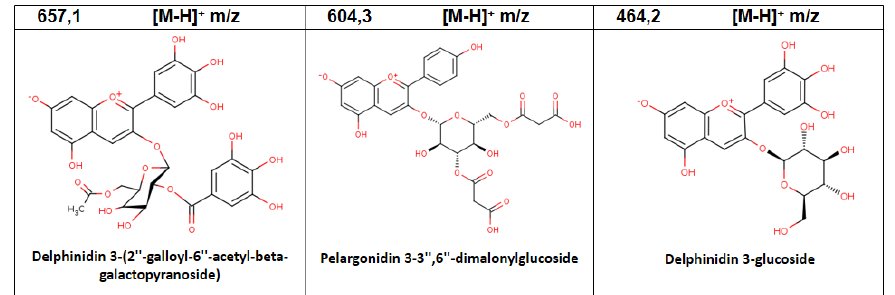
Figure 3. Chemical structure of the anthocyanins identified by LC ‐ MS/MS analysis for the aqueous extracts of in vitro plant of A. chilensis .